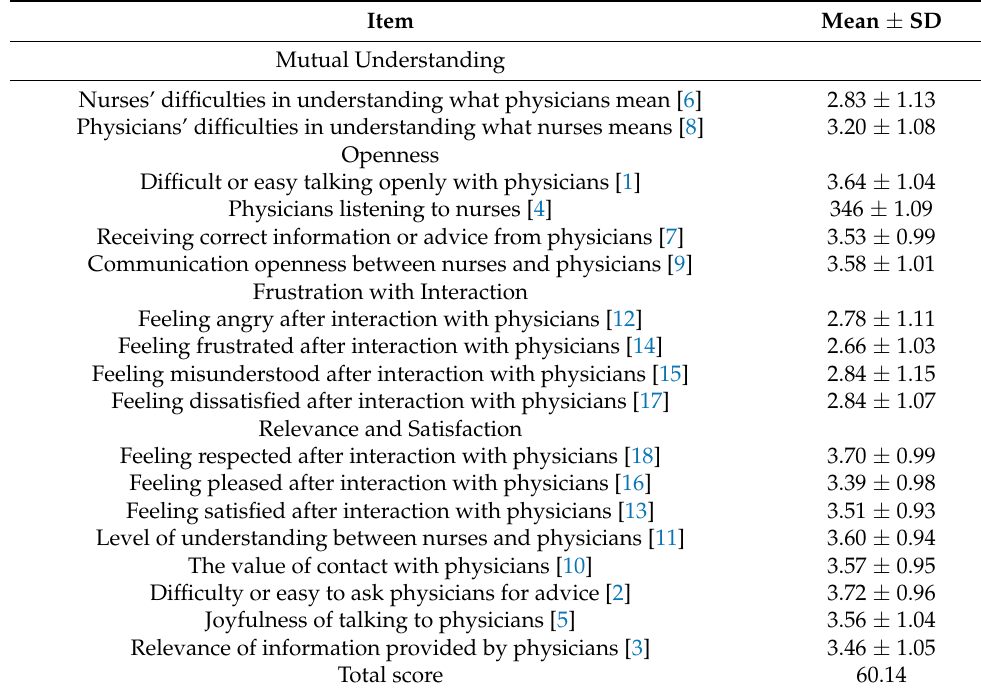
Table 2. Nurses’ perceptions of quality of nurse–physician communication in Emergency